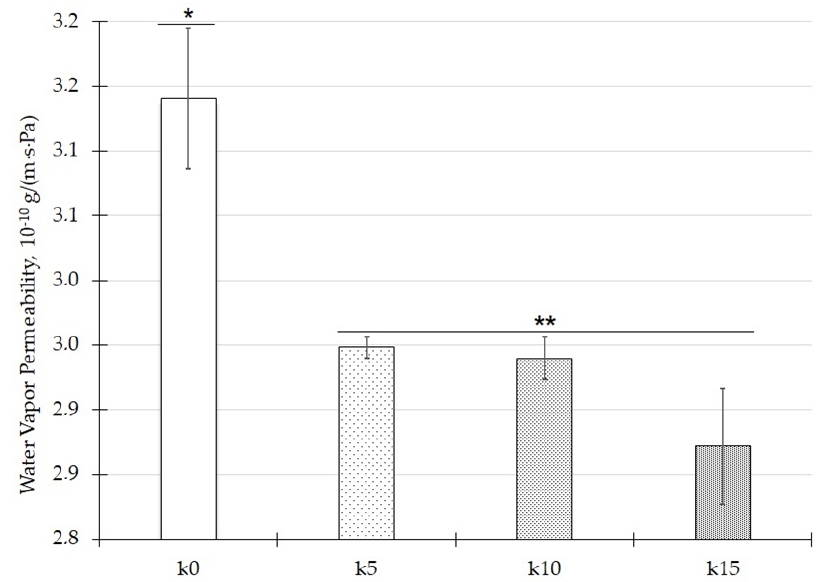
Figure 4. Water vapor permeability; data given are mean ± SD; (*, **) the marker means a group that is statistically significantly different ( p < 0.05).